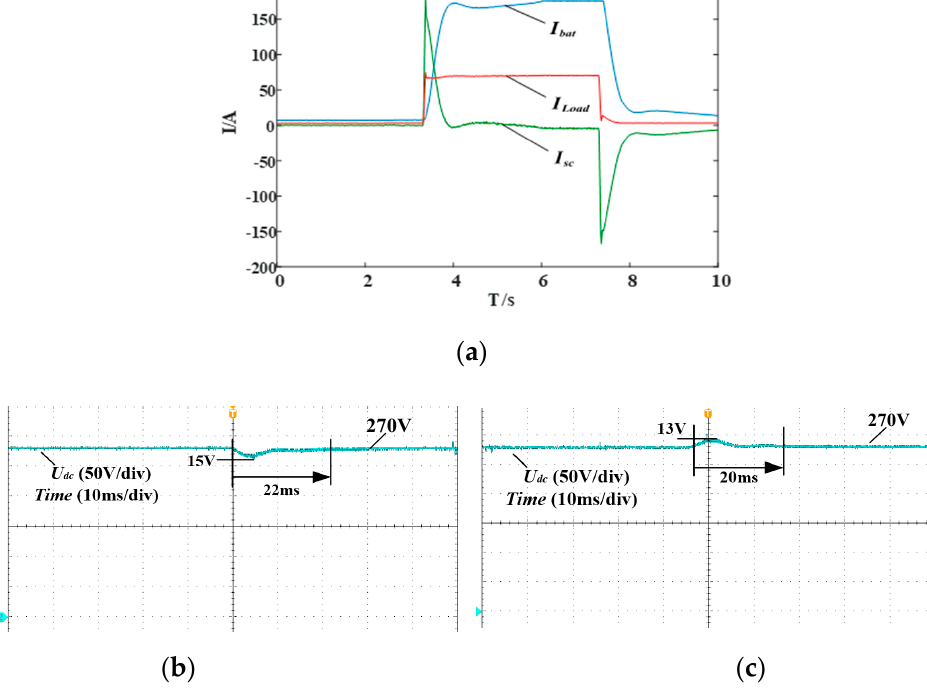
Figure 14. Sudden load and unload test waveform: ( a ) Current waveform; ( b ) Sudden load bus voltage waveform; ( c ) Sudden unload bus voltage waveform.